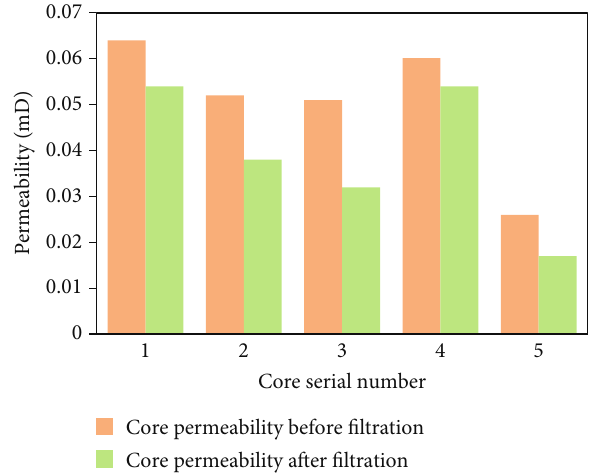
Figure 8: Relationship between fracturing fl uid retention and porosity.